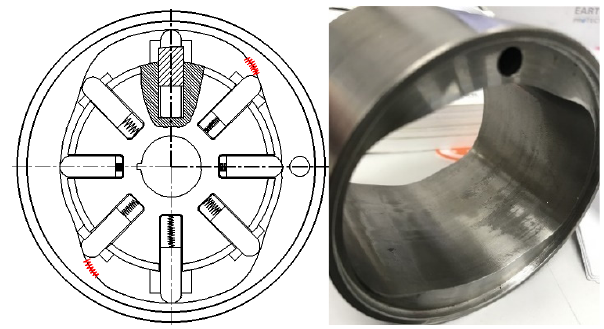
Figure 2. Stator wear location diagram.